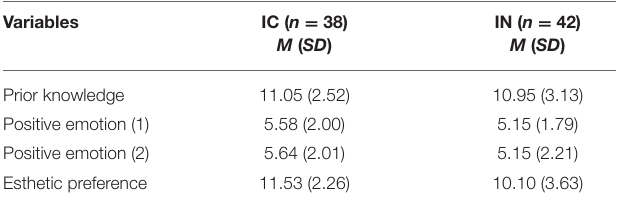
TABLE 1 | Means and standard deviations of all variables for the two groups in the preliminary experiment.